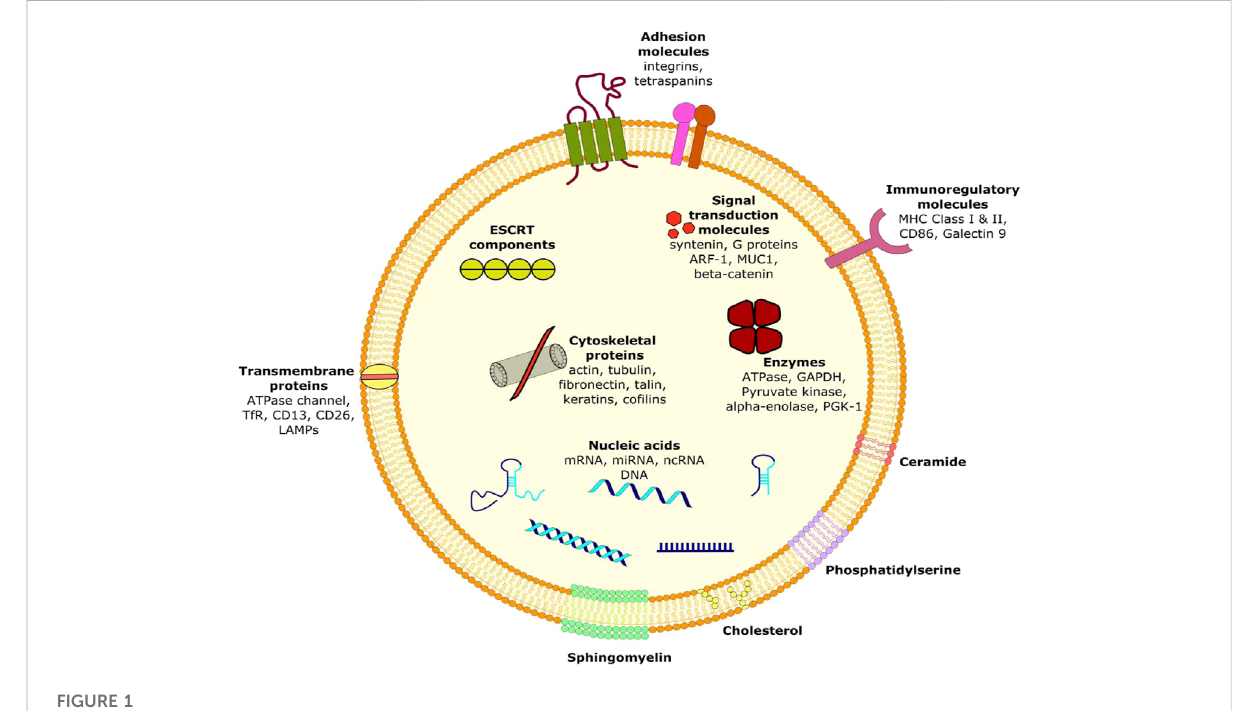
FIGURE 1 Ultrastructure of exosome showing its composition.